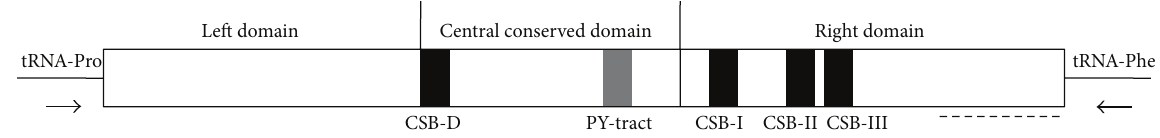
Figure 1: The mtDNA CR structure of Mugil cephalus . Arrows indicate locations of primer binding sites. Broken lines indicate location of variable number of tandem repeats (CSB—conserved sequence